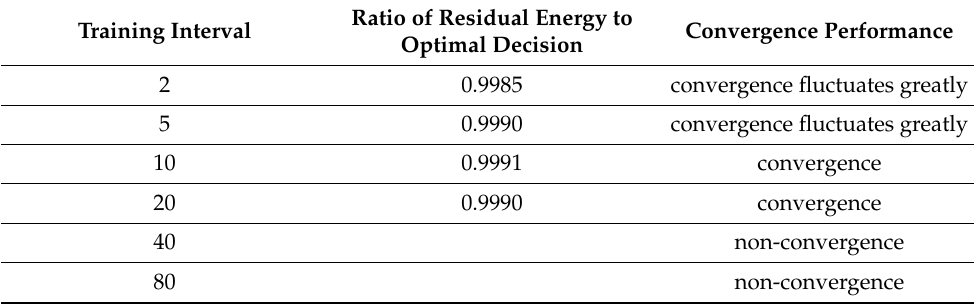
Table 1. The effect of training interval δ on algorithm performance. Here, we set N = 8.